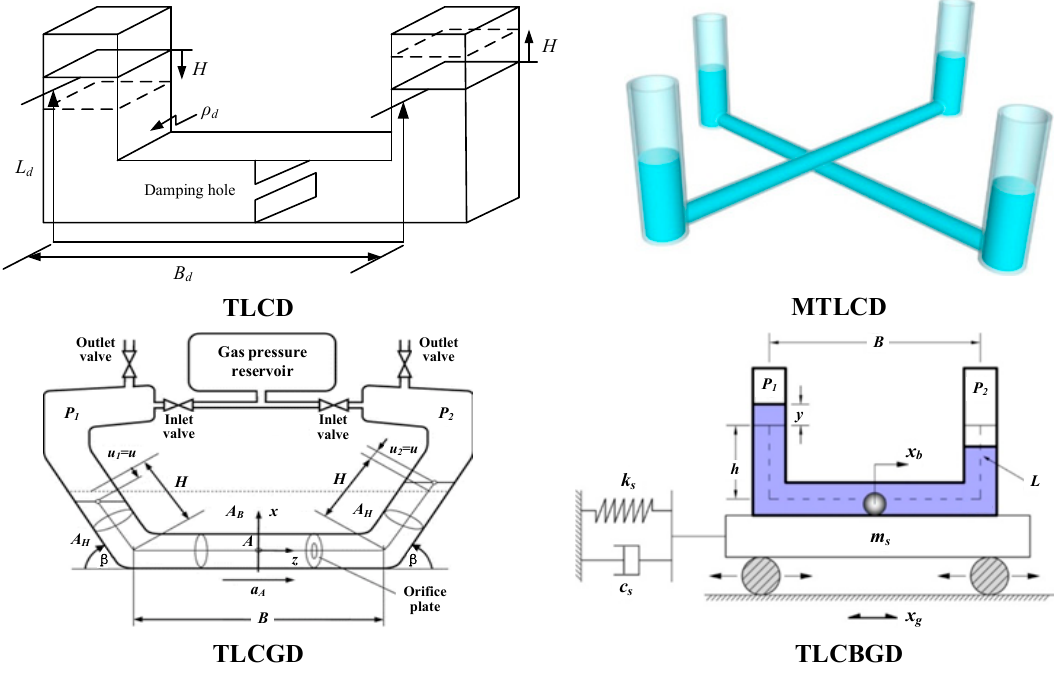
Figure 3. Schematic diagrams of the structures of several types of tuned liquid dampers [26,29–31]. A TMD is usually installed in the nacelle of a wind turbine and consists of a mass block, a damping element, and a controller. When the system is unbalanced, the position of